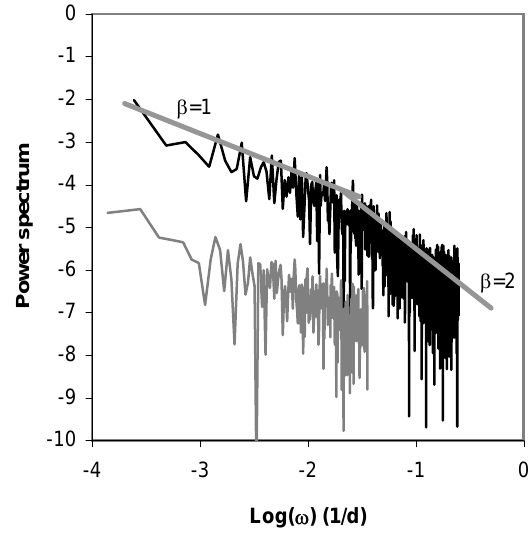
Fig. 2. Bilogarithm plot of the fluctuation function F(n) vs. time Figure 2 . Bilogarithm plot of the fluctuation function F ( n ) vs. time scale n , for a RSS having Fig. 3. Power spectrum of a flicker RSS, with step-like interpolation scale n , for a RSS having flicker-noise correlation properties (the- flicker-noise correlation properties (theoretical α = 1.03). The DFA results are displayed for the and resampled by 0.07 d − 1 (grey) and 0.14 day − 1 (black). The oretical α = 1 . 03). The DFA results are displayed for the series series interpolated by both step-like and linear method, and resampled by both 0.07 day -1 and 0.14 Figure 3 . Power spectrum of a flicker RSS, with step-like interpolation and resampled by 0.07 d -1 two curves have been shifted by 2 logarithm units for clarity. The interpolated by both step-like and linear method, and resampled by day -1 frequencies. The label “correct.” refers to DFA coupled to PRS and small- n correction different spectral exponent of the high- and low-frequency branches (grey) and 0.14 day -1 (black). The two curves have been shifted by 2 logarithm units for clarity. The both 0.07 day − 1 and 0.14 day − 1 frequencies. The label “correct.” techniques (see text). As the calculated F ( n ) functions almost overlap, they have been multiplied by is different spectral exponent of the high- and low-frequency branches is displayed. refers to DFA coupled to PRS and small- n correction techniques an arbitrary factor so as to be shifted for clarity. This procedure was repeated in the following (see text). As the calculated F(n) functions almost overlap, they figures whenever required. have been multiplied by an arbitrary factor so as to be shifted for